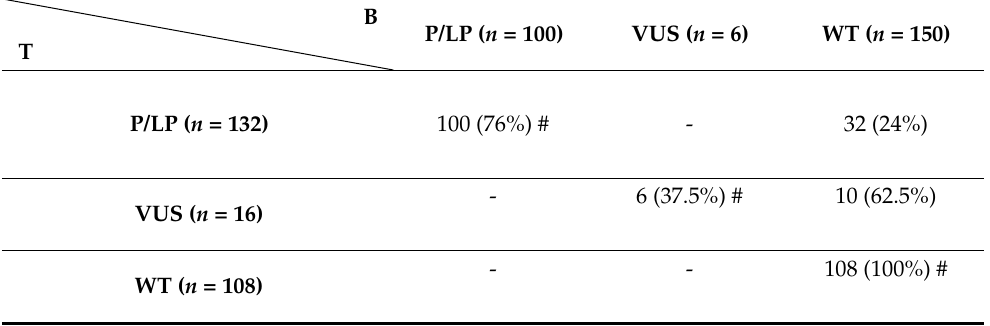
Figure 3. The new workflow for the management of women affected by ovarian cancer. Blue boxes: The workflow for the management of women affected by OC proposed in 2019 [20]. Red boxes: new steps introduced starting from January 2020. OC: ovarian cancer; P/LP: pathogenic/likely pathogenic variants; VUS: variant of uncertain significance; HBOC: hereditary breast and ovarian cancer syndrome; MLPA: Multiple-Ligation Probe-Amplification; LR: Large Rearrangements. Table 4. Crosstabulation of tumor and blood test results, available for 256 women affected by EOC. The number of cases and the percentages were tabulated according to the detection of pathogenic/likely pathogenic variants, VUS or negative BRCA status (wild type). B: blood test; T: tumor test; P/LP: pathogenic/likely pathogenic variants; VUS: Variants of Unknown clinical Significance; WT: Wild